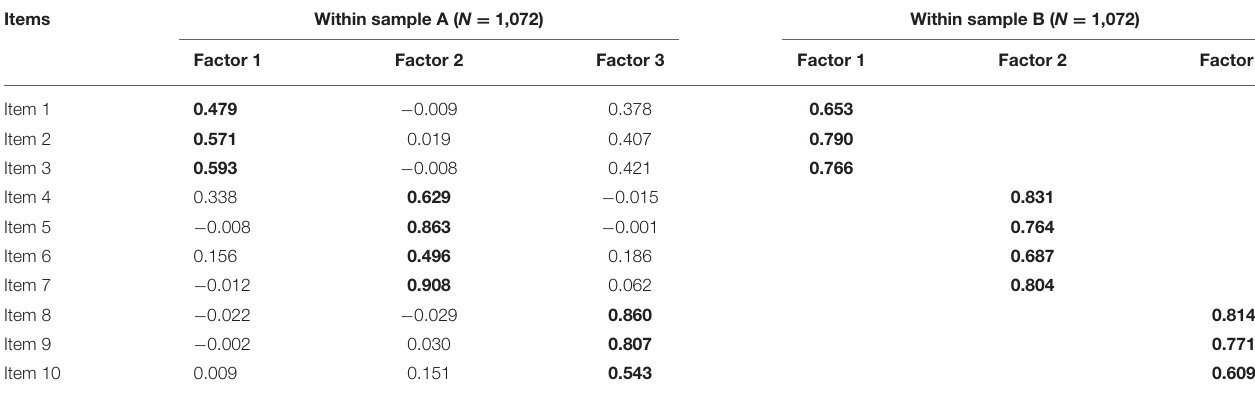
TABLE 4 | Loadings and commonality of each item on three factors in EFA and